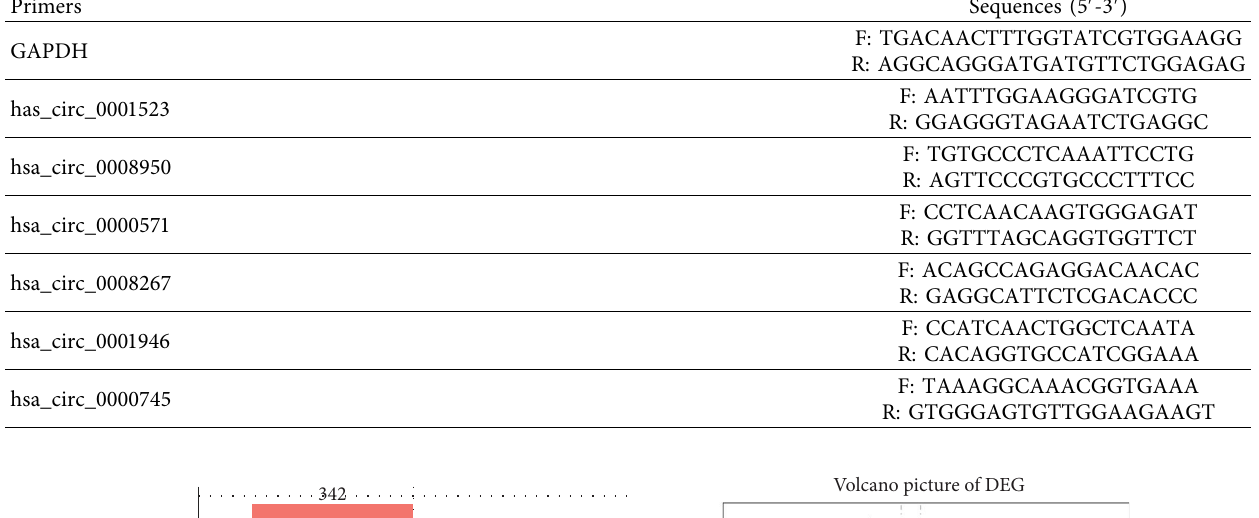
Table 2: Sequences of all primers for